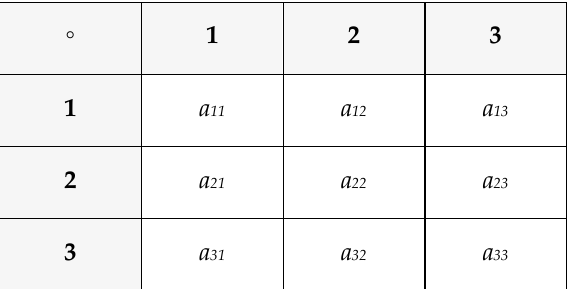
Table 12. A LA- and RA-hypergroup.